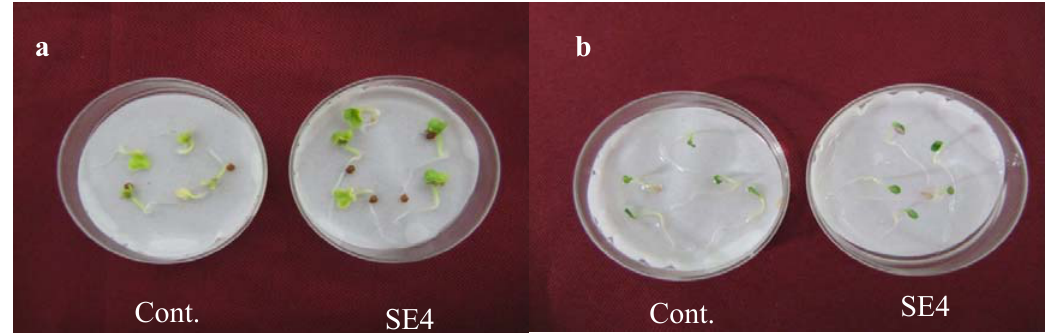
Figure 2. Effect of ethyl acetate extract (500 ppm) on the growth of ( a ) lettuce and ( b ) chinese cabbage